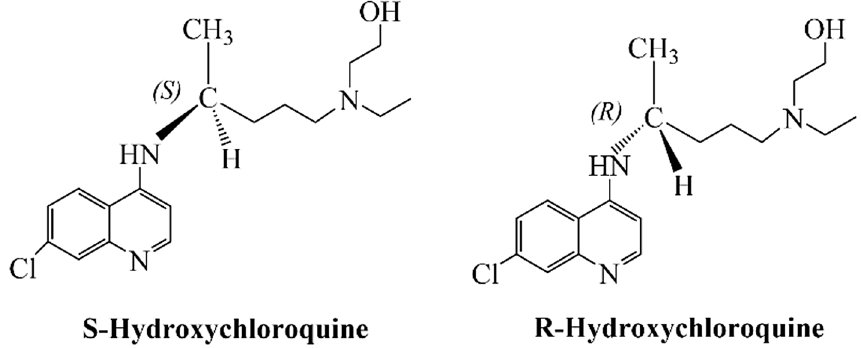
Figure 1. Chemical structures of hydroxychloroquine